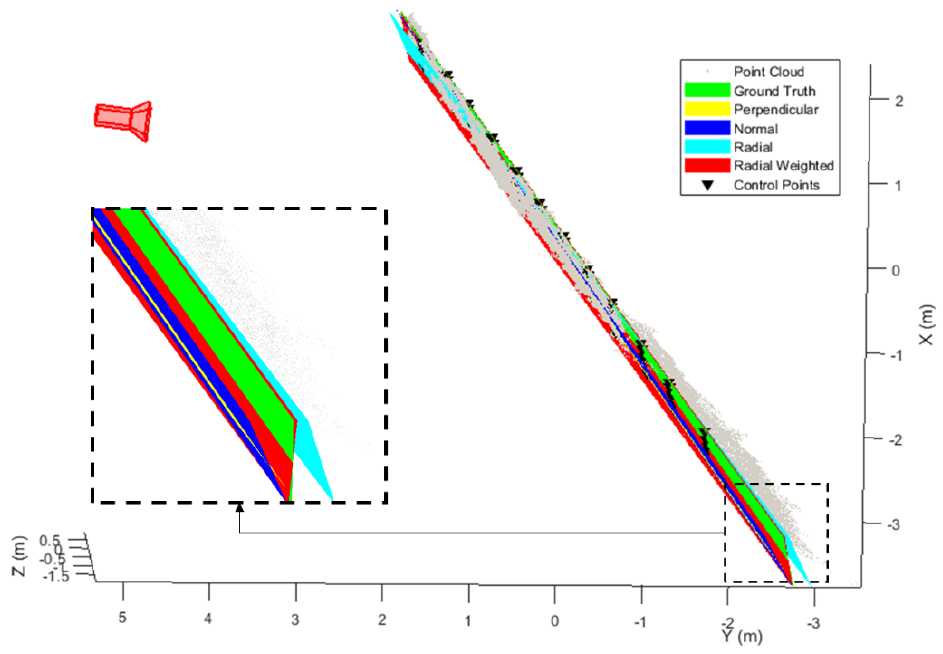
Figure 13. Qualitative results of the different plane fitting methods.